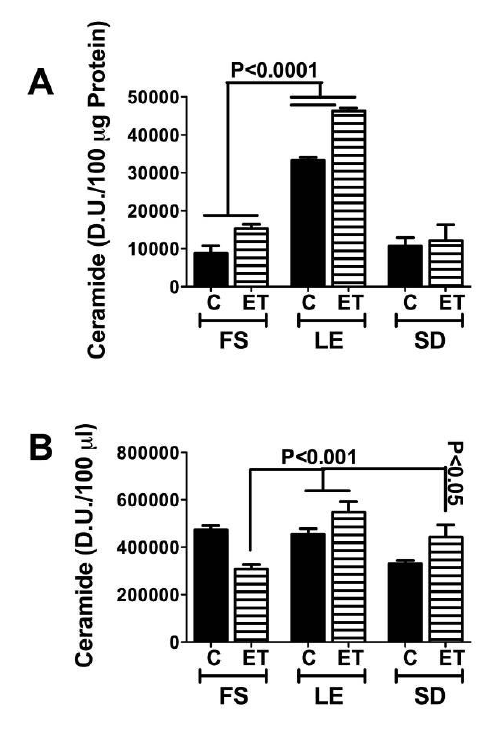
Figure 3. Genetic factors governing degrees of alcohol-induced hepatic steatosis and neurodegeneration correlate with liver and serum ceramide content as measured by ELISA or dot blot analysis. Immunoreactivity was detected with HRP conjugated secondary antibody and enhanced chemiluminescence reagents, and quantified by digital imaging. Significant P-values are indicated over the